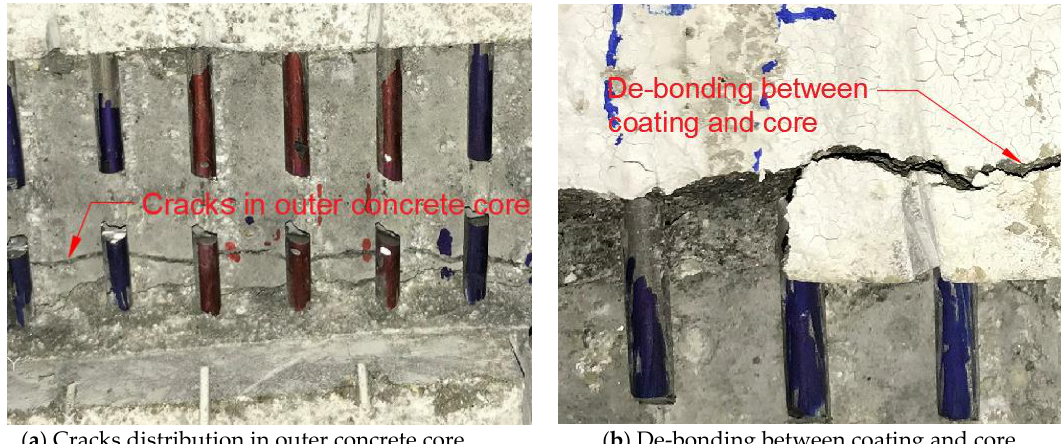
Figure 16. Phenomena of test pipe after wire breakage.